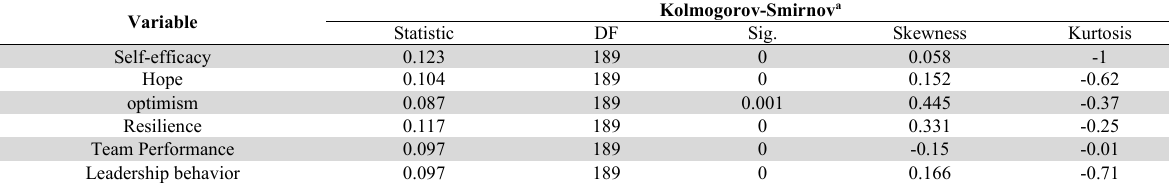
Normal distribution of study variables